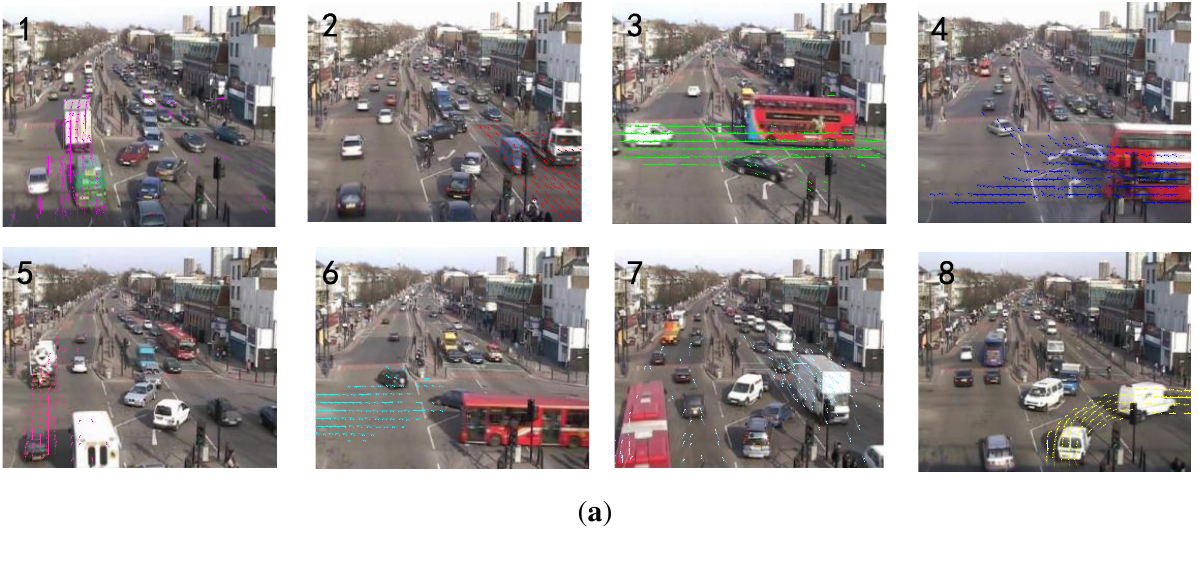
Figure 6. The experimental results on the intersection dataset. ( a ) Top: illustration of the top 8 topics; ( b ) Bottom: the timelines of the top 8